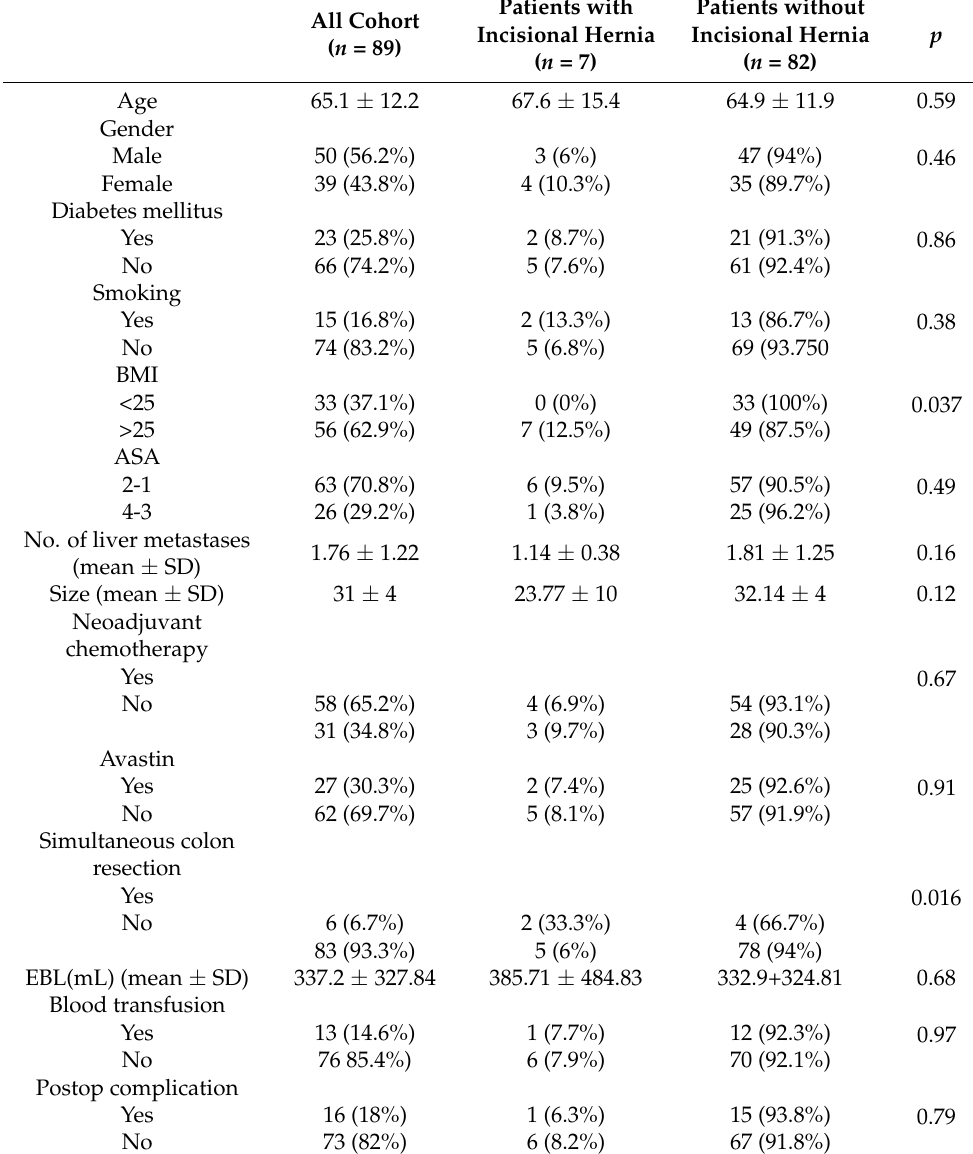
Table 1. Patient demographic and clinical characteristics.